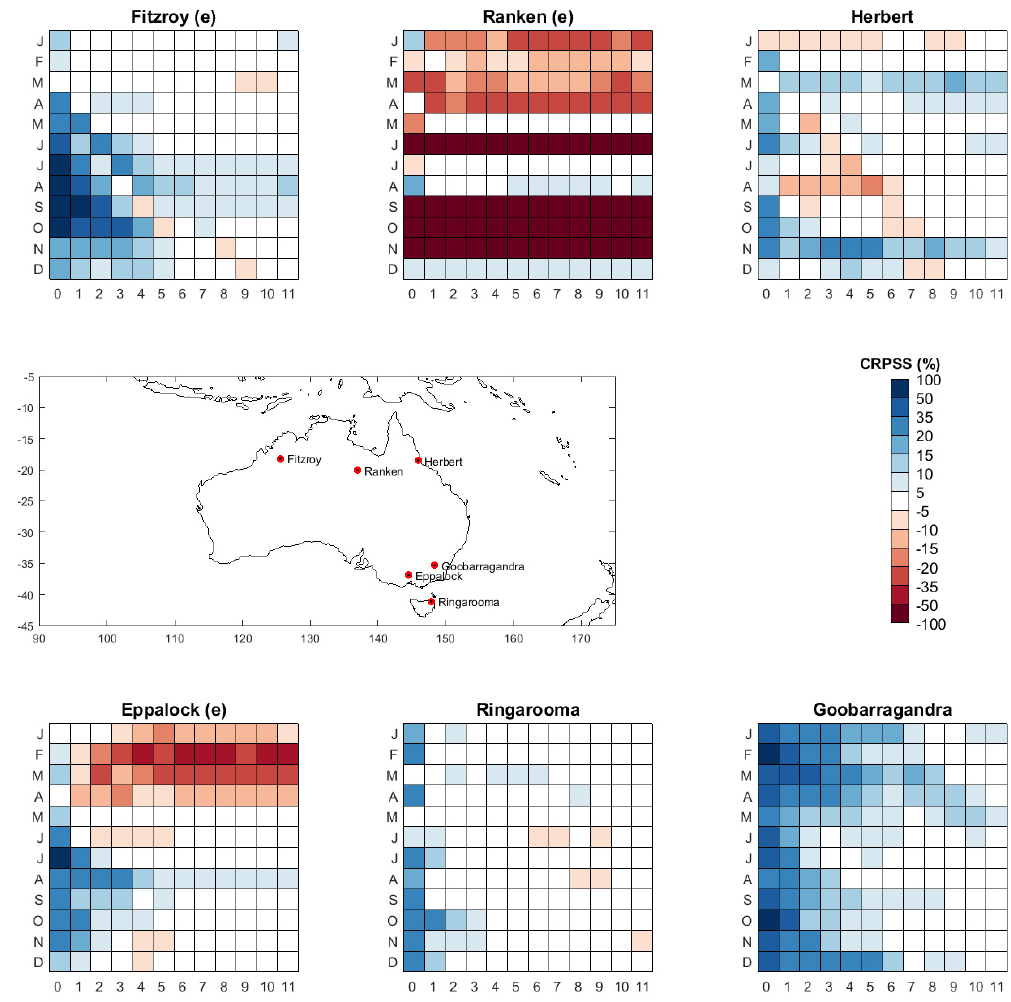
Figure 4. Skill (CRPSS) for FoGSS forecasts (base case). Ephemeral catchments are denoted with (e). Target months are shown on the vertical axes, and target lead times on the horizontal axes. Centre map gives catchment